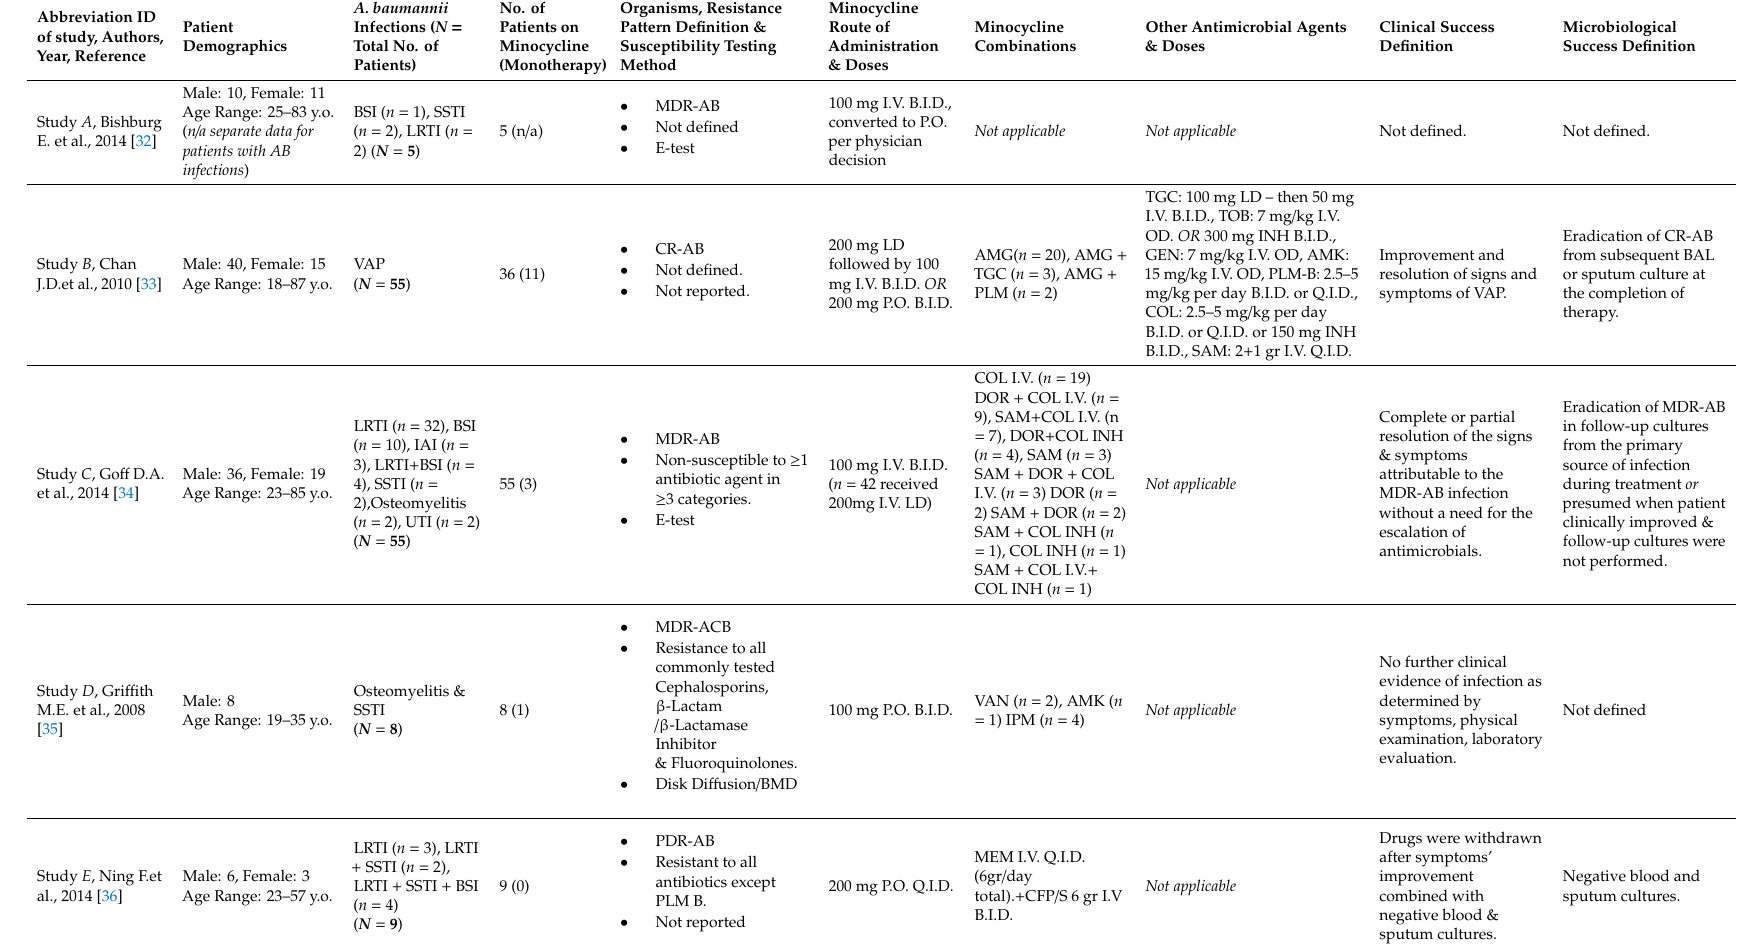
Table 3. Characteristics of included clinical